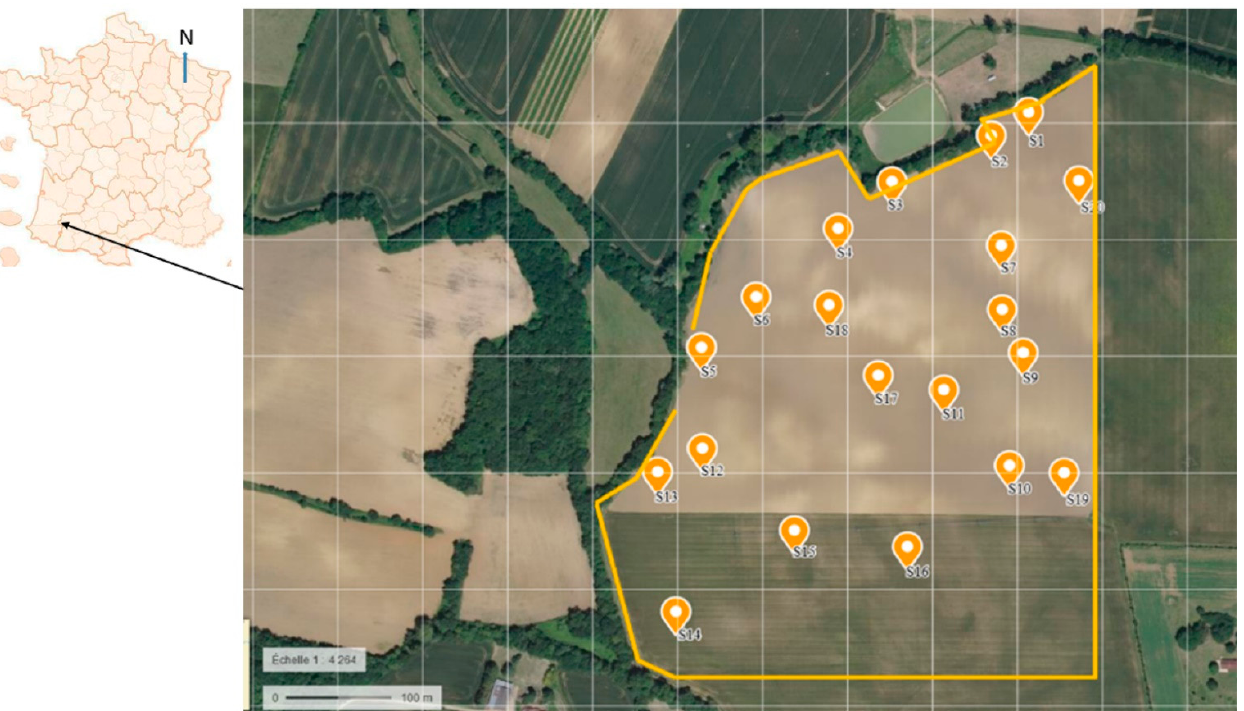
Figure 1. The geographical location of the study in south France and the spatial distribution of the 20 sites (S1 to S20) of P. halstedii isolates in the sunflower field (satellite image from https://www.ge ‐ oportail.gouv.fr/ accessed on 5 September 2022). //www.geoportail.gouv.fr/ accessed on 5 September